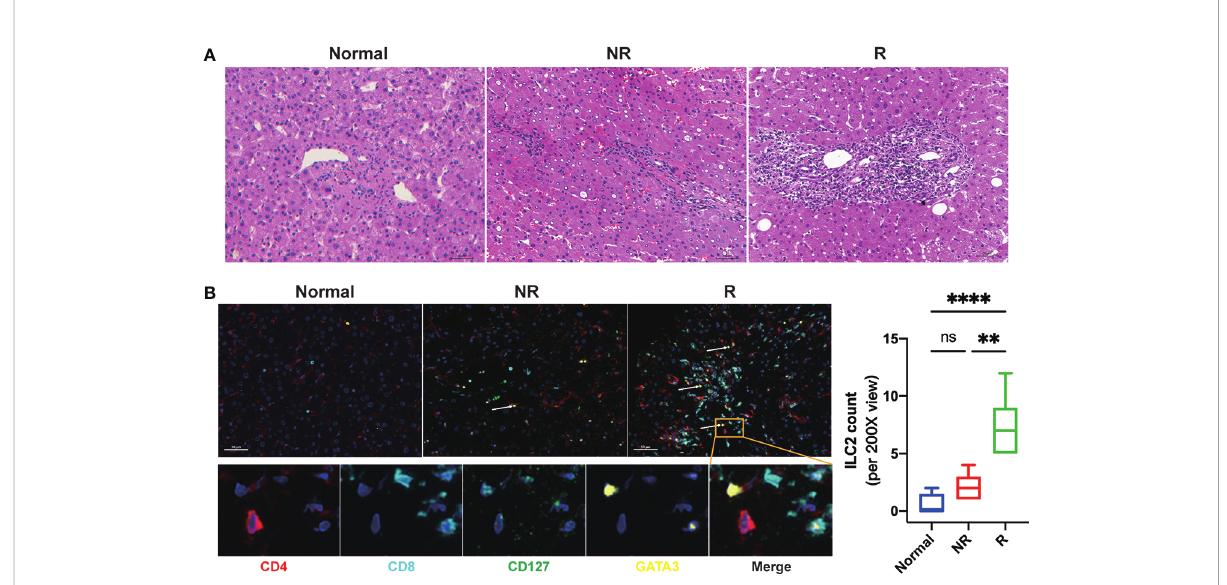
FIGURE 2 Signi fi cantly increased allograft in fi ltrating immune cells and group 2 Innate lymphoid cells (ILC2s) were related to acute rejection after liver transplantation. (A) Representative images of hematoxylin and eosin (H&E) of fi xed and paraf fi n-embedded human liver tissue sections indicated that compared with that of the normal and non-rejection group, the in fi ltrations of immune cells in allograft were signi fi cantly increased in the rejection group. Scale bar, 50 m m. (B) Multiplex immuno fl uorescent staining of ILC2s in liver tissues of each group showed that hepatic ILC2s (CD127+GATA3+; white arrow) were increased after LT, particularly in the rejection group. Scale bar, 50 m m. Fixed and paraf fi n-embedded tissue sections were labeled against CD4 (red), CD8 (cyan), CD127 (green), and GATA3 (yellow) using Opal reagents (Akoya Biosciences).